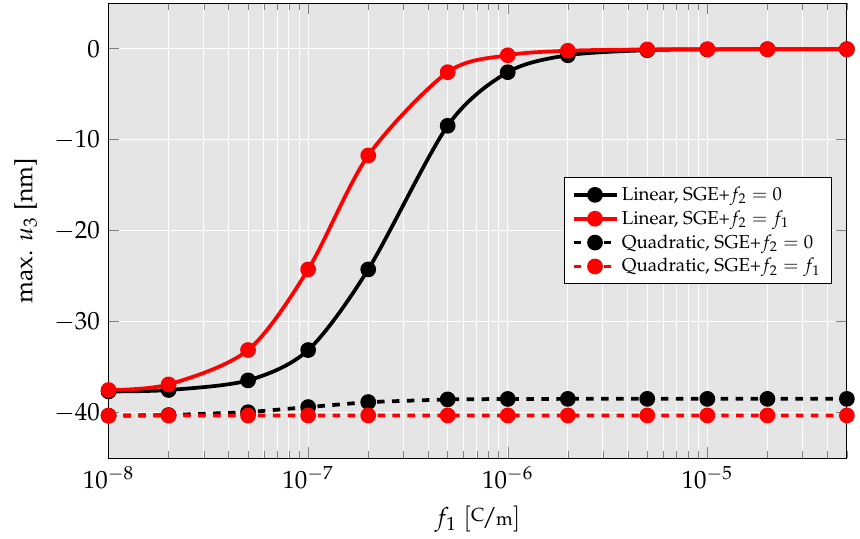
Figure 24. Maximum deflection u 3 of the cantilever beam calculated by using linear and quadratic element for various flexoelectric